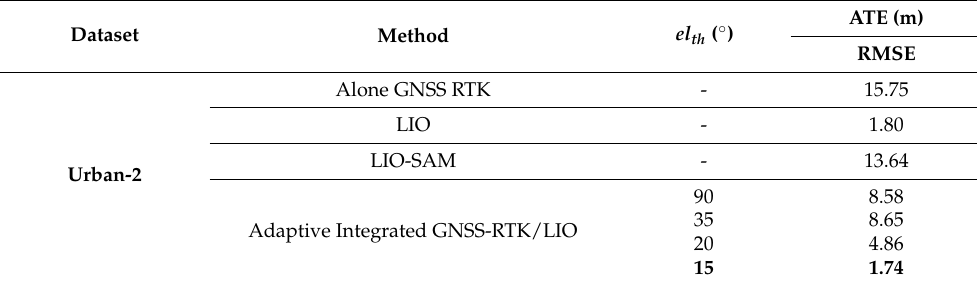
Table 4. ATE of the trajectory estimated by different pipelines on urban-2.